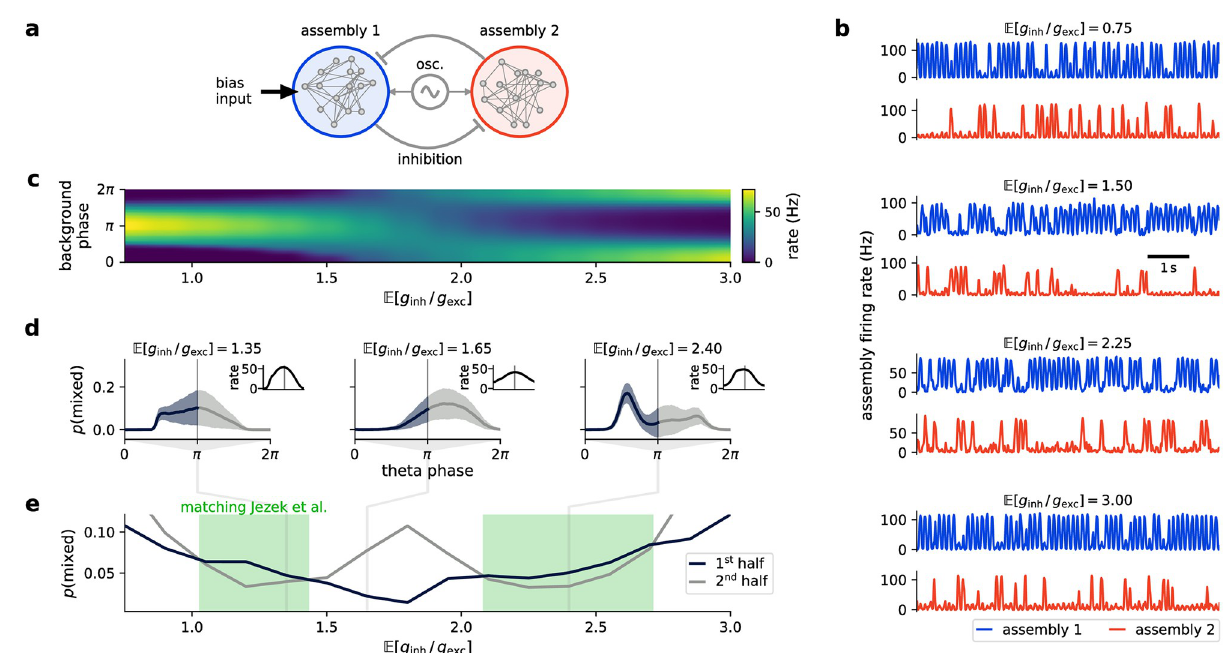
Fig 7. Relating model features to experimental data. (a) Simple network model reproducing place-cell flickering behavior. The model consists of two assemblies of spiking neurons with recurrent excitation and lateral inhibition. Assemblies 1 (blue) and 2 (red) encode the correct and incorrect interpretation of the spatial context, respectively. Neurons in assembly 1 receive a bias input current, and all neurons receive oscillatory background input. (b) Example model activity (cf. Fig 3c in [44]). Assembly firing rates encoding correct and incorrect interpretations of context are shown in blue and red, respectively. The model behavior holds as the ratio of the mean inhibitory to excitatory background conductance is varied (plot shows = g � 2 f 0 : 75 ; 1 : 5 ; 2 : 25 ; 3 g ). (c) As E ½ g = g � changes, the minimum firing rate shifts along the background input phase. The background input E ½ g inh exc inh exc cycles are defined here as having their onset time (phase zero) when the input rate is at its minimum, i.e., the maximum input occurs at phase π . (d) Probability of mixed interpretations during a cycle. Solid line shows mean, shaded area standard deviation over N = 100 network runs of 50 s each. Insets show background input (left) and network firing rate (right, cf. panel b). To match [44], the phase is reordered for every value of E ½ g that phase zero is aligned with the minimum firing rate in the network (see right inset). (e) Mixed state probability in the first and second half of network activity cycle as the mean background conductance ratio is varied. Green shading shows areas in which the mixed probability is larger in the first half of the cycle, matching the results of